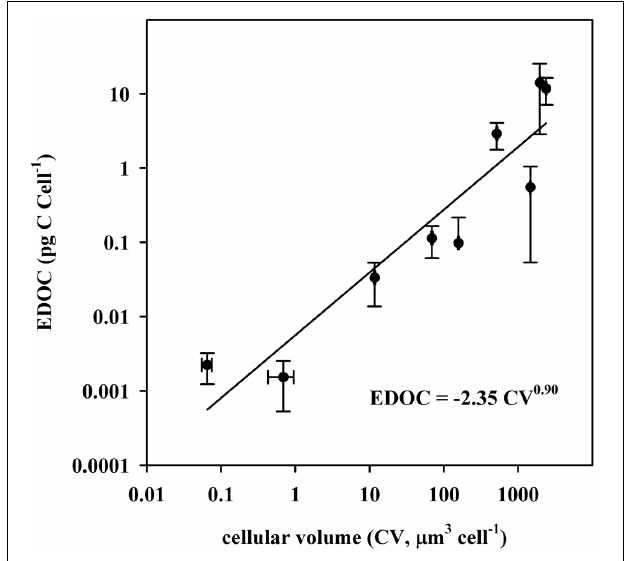
FIGURE 1 | The relationship between the cellular volatile and semivolatile organic carbon content (EDOC) and the cell volume (CV) of various phytoplankton species. The solid line shows the fitted orthogonal fit ( R 2 = 0 . 86, p < 0 . 05, n = 9, Equation 1). Both the X and Y axis are on a logarithmic